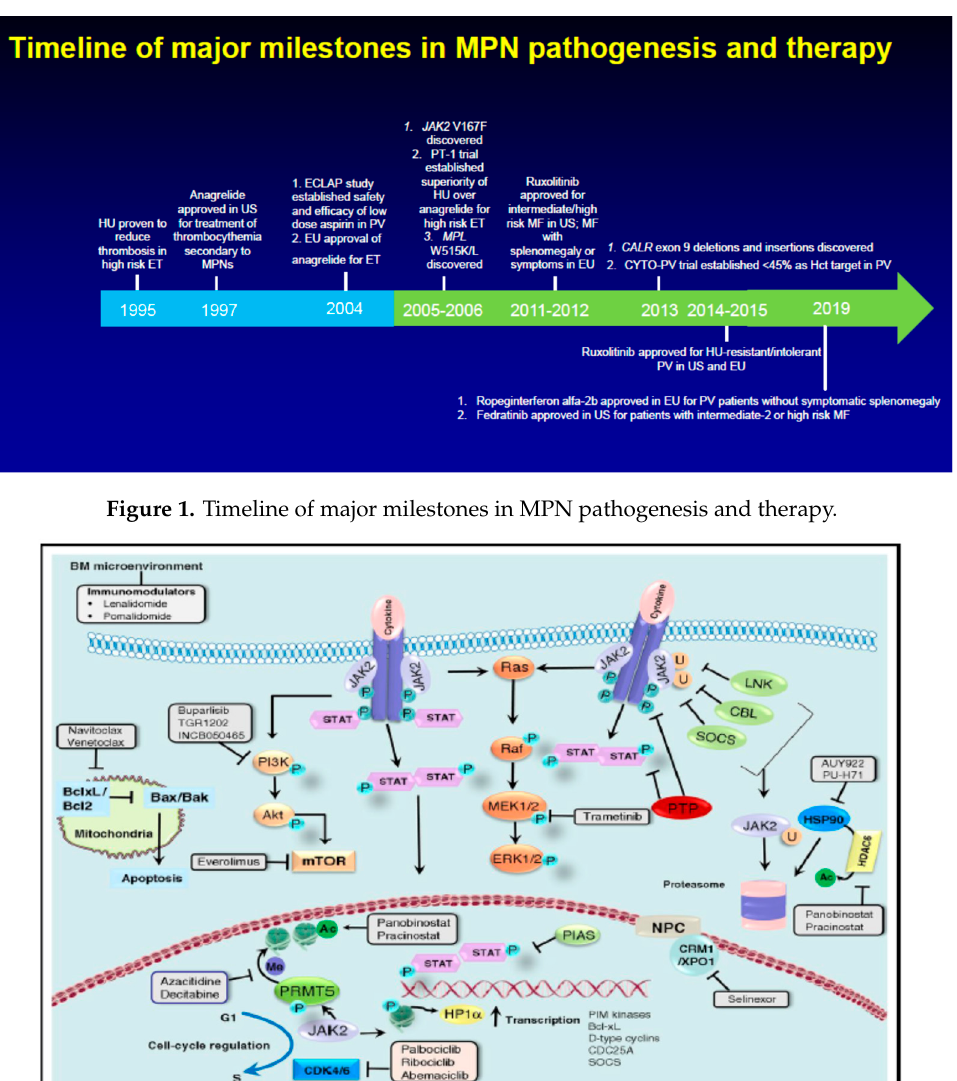
Figure 2. JAK2 transduces cytokine and growth factor signals from membrane-bound receptors